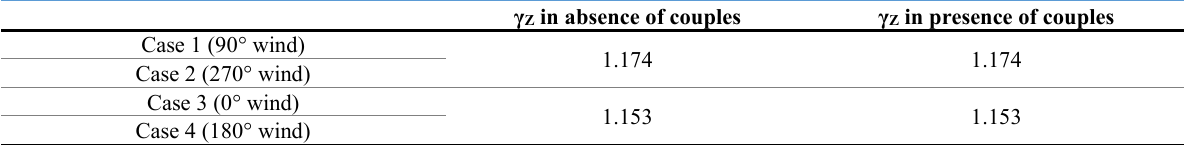
Table 5. γ Z coefficient values in absence or presence of torsional